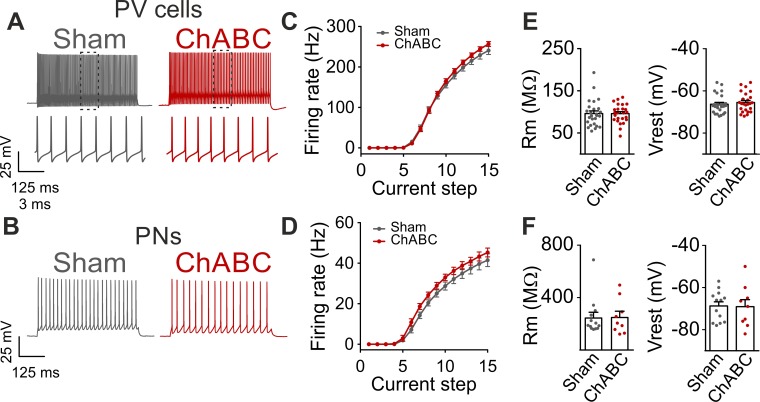
Firing dynamics and passive properties are not altered by PNN removal in adult animals.(A) Characteristic firing pattern of PV cells in response to depolarizing current injections, in control condition (Sham, grey) and in PNN-depleted animals (ChABC, red). Insets illustrate firing at an expanded timescale corresponding to the dotted region in the upper part. (B) Example firing of PNs in presence (Sham, grey) and absence (ChABC, red) of PNNs. (C–D) Average frequency-current (f–i) curves of PV cells (C) and PNs (d). (E–F) Passive properties of PV cells (E) and PNs (F). PV = parvalbumin positive interneuron. PN = principal neuron. All values are in Table S1.
10.7554/eLife.41520.009Figure 2—figure supplement 2—source data 1.Source data for Figure 2—figure supplement 2C–F.